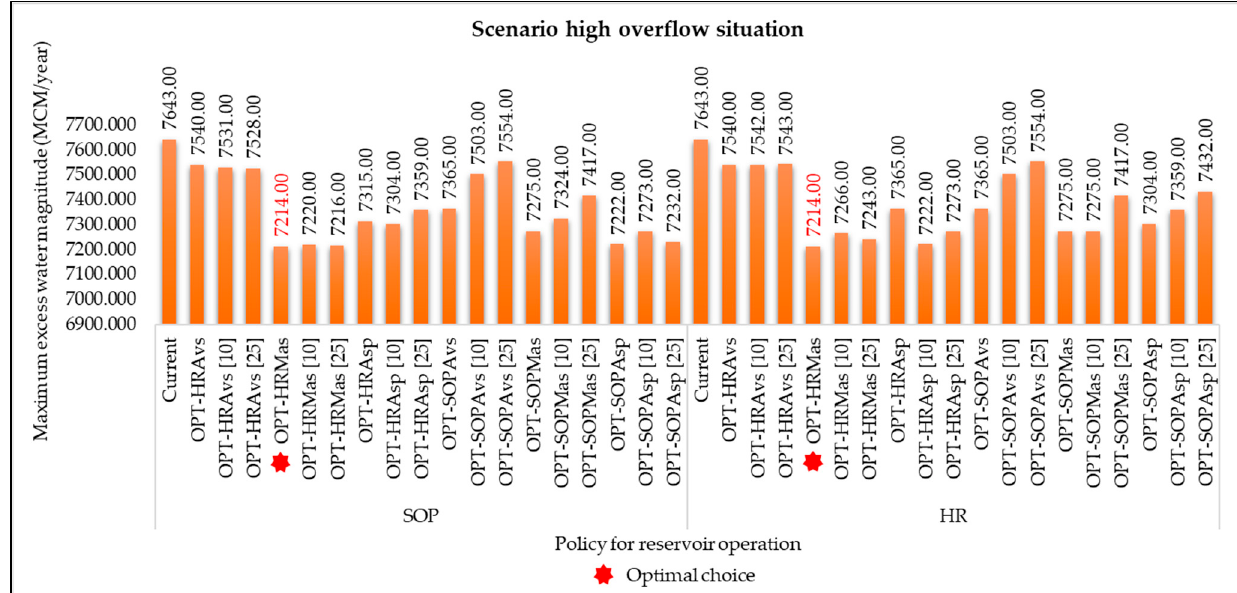
Figure 11. Optimal choice for operating rule curves under high overflow scenario.